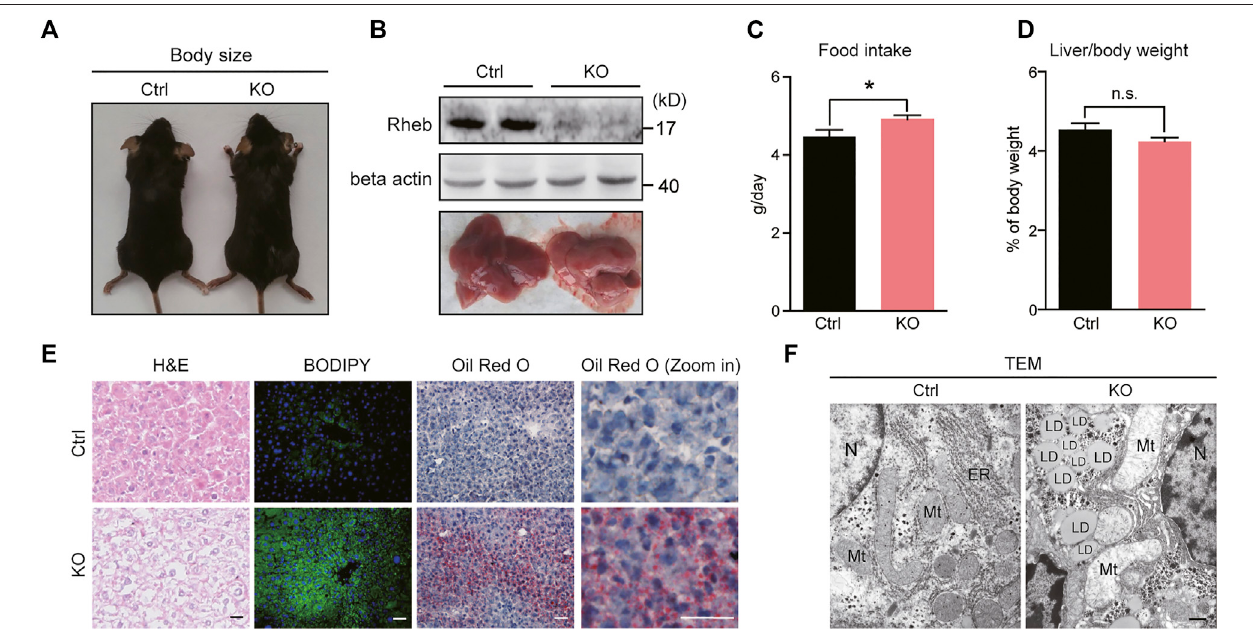
FIGURE 1 | Hepatic deletion of Rheb causes spontaneous hepatosteatosis. (A) Body size of control and Rheb KO mice (6-week old). (B) Western blots of Rheb protein in the liver of control (Rheb f/f) and Rheb KO mice(Rheb f/f; Alb-cre); photographs of livers from control and Rheb KO mice (6-week old, lower panel). (C) Slightly increasedfoodconsumptionof Rheb KOmice(control:n=3, Rheb KO: n =6). (D) Theratioofliverweighttobodyweightofcontrol(n=9)and Rheb KOmice( n =10)(6- week-old). (E) H and E (left panel, scale bar, 20 μ m), bodipy (middle panel, scale bar, 50 μ m), and Oil Red O (right panel, scale bar, 50 μ m) staining showing hepatosteatosis in the liver of Rheb KO mice (6-week-old). (F) TEM showing lipid droplets in the liver of Rheb KO mice (6-week-old). Scale bar, 1 μ m. Data represent mean ± SEM. *p < 0.05. n.s. no statistical signi fi cance.